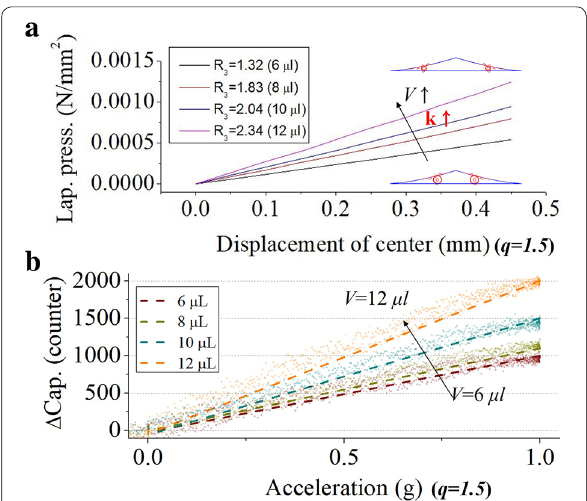
Fig. 5 Effect of the LM volume on the a spring constant and b